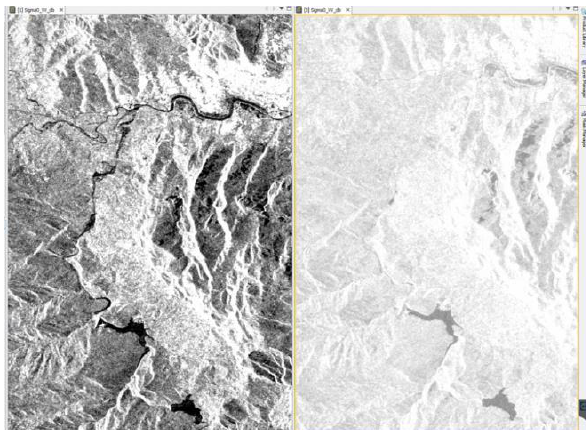
Figure 5. Results of the cross-comparison using S1